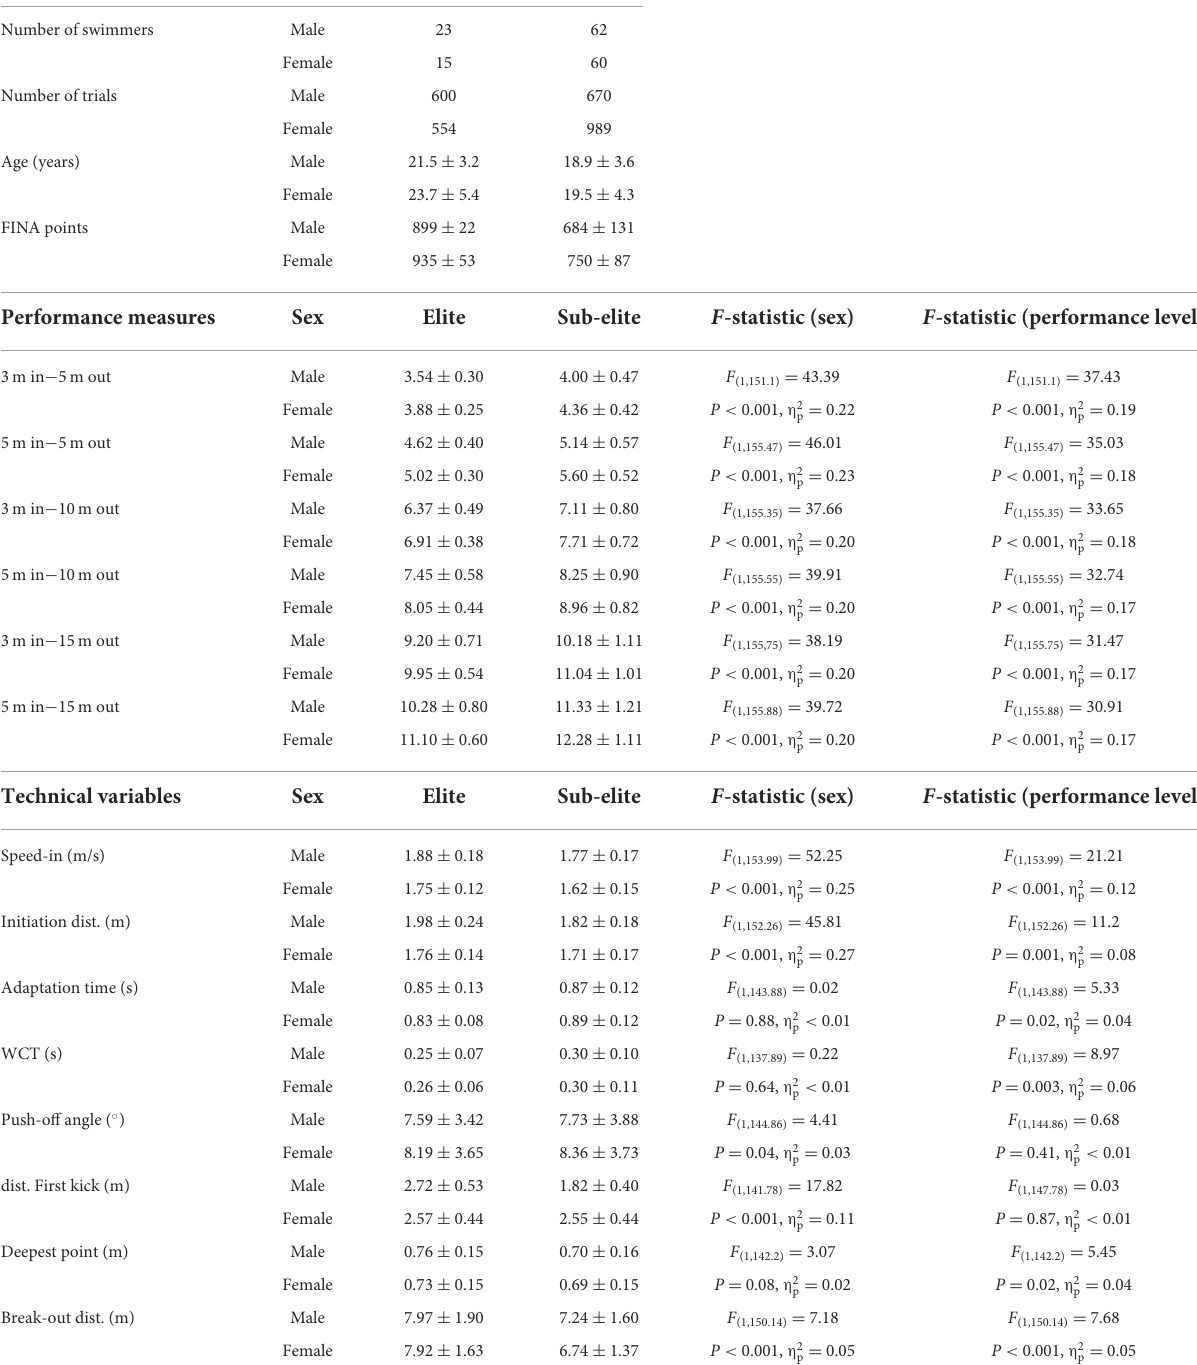
TABLE 2 Descriptive statistics and means and standard deviations of performance measures and technical variables for the elite male and female and sub-elite male and female subgroups separately. Descriptive